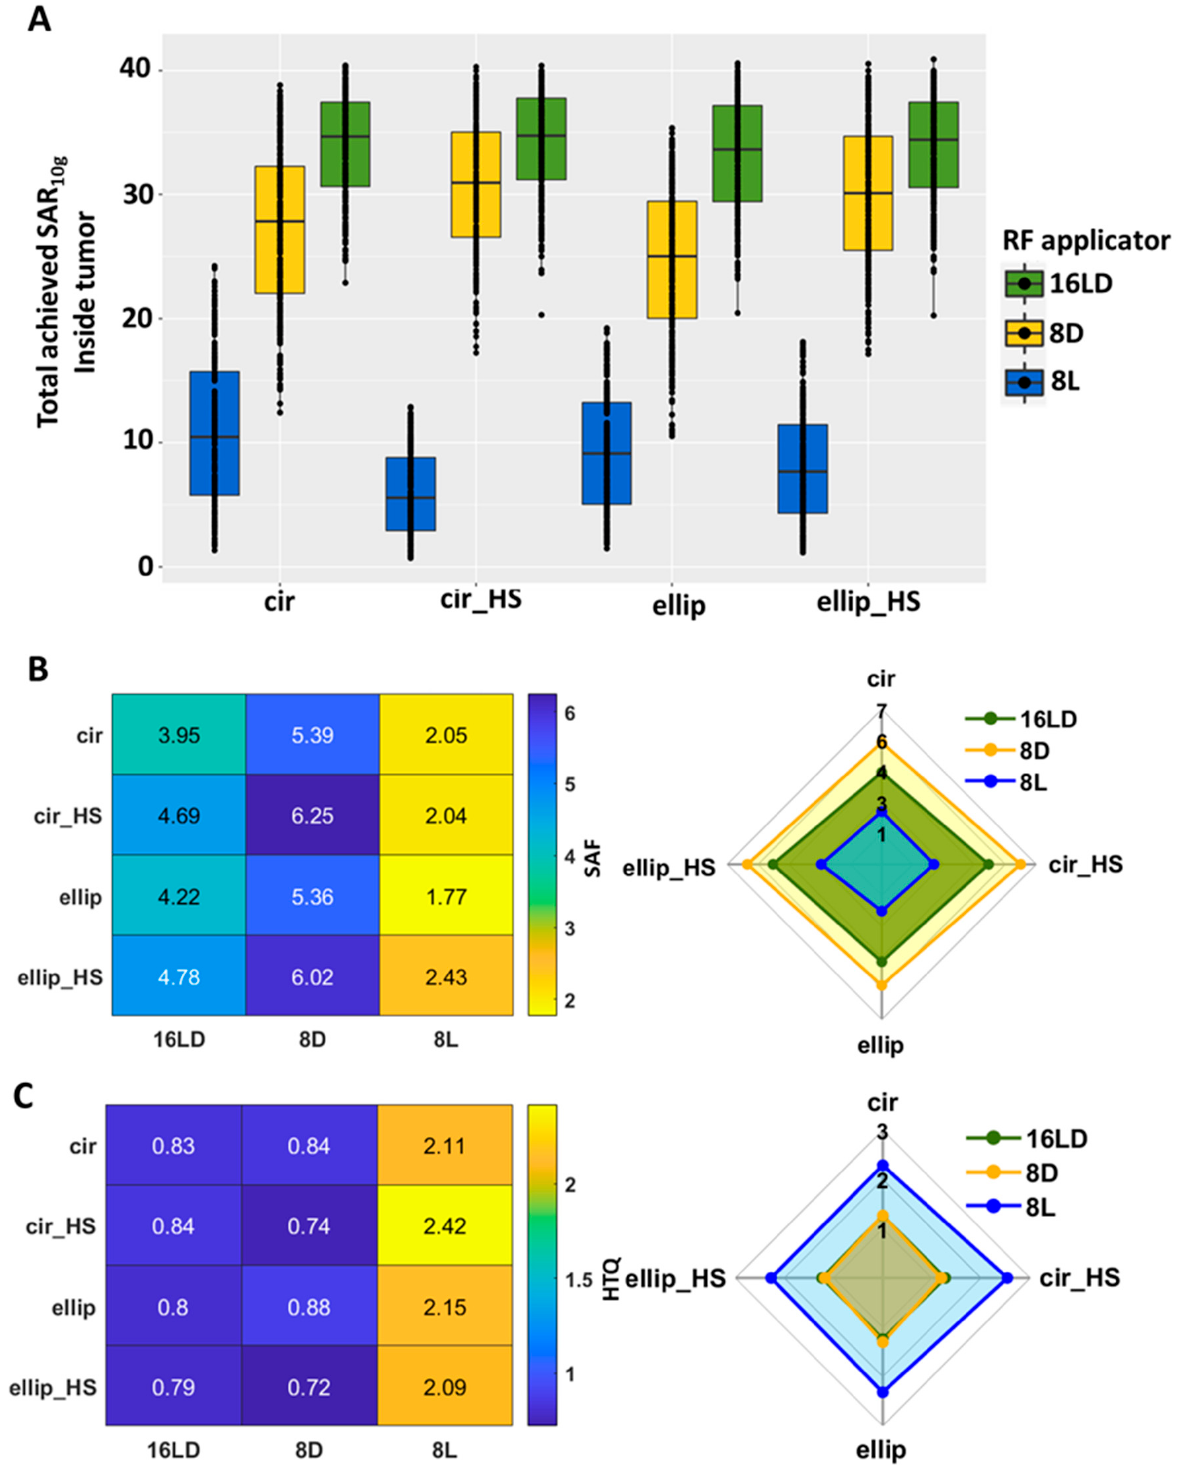
Figure 10. Quantification of SAR 10g of targeted RF heating optimization, SAR amplification factor (SAF), and hotspot-to-target quotient (HTQ). ( A ) The 16LD ThermalMR RF applicators showed sig- nificantly greater total SAR 10g inside the tumor TV compared with the 8D and 8L RF applicators. The 16LD cir , 16LD cir_HS , 16LD ellip , 16LD ellip_HS ThermalMR RF applicators show a 24%, 12%, 14% and 34% increase of mean SAR 10g over 8D variants. Statistical analysis shows for the cir_HS ThermalMR RF applicator variant that SAR 10g was 34.7 ± 6.57 (median ± IQR) compared with 30.9 ± 8.47 for